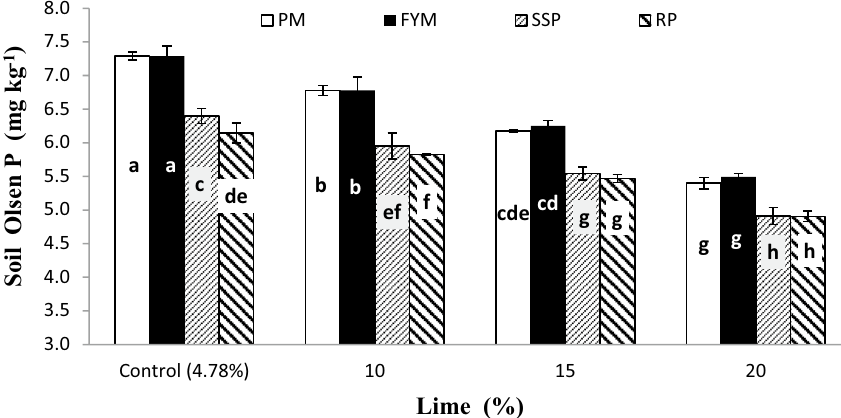
Figure 12. Soil post-harvest P (mg kg −1 ) as affected by P sources and Lime. Graph bars having different letters are significantly different at α = 0.05. Errors bar represent standard error for the mean of three values.